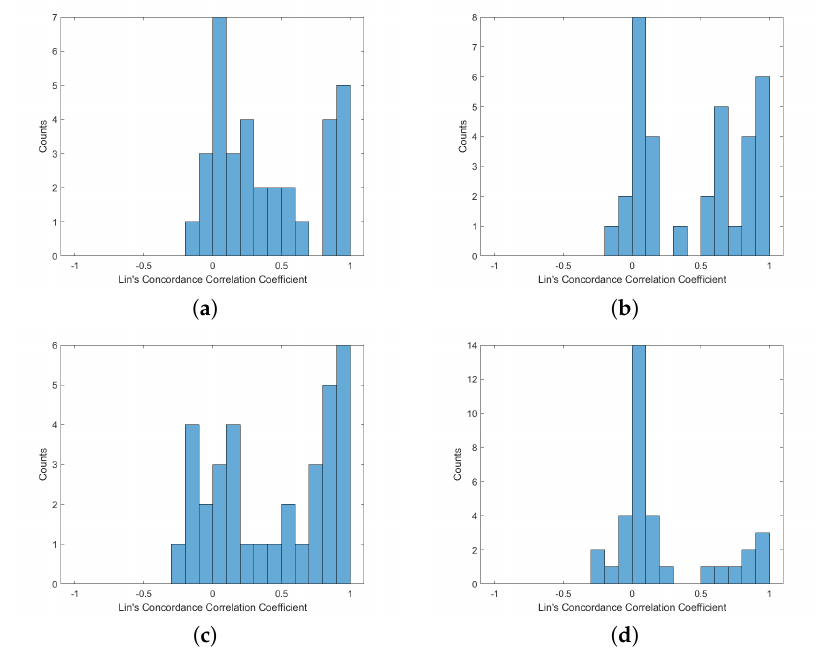
Figure A4. Histogram of Lin’s Concordance Correlation Coefficient from PPG-HRV and BCG-HRV, position “Up”: ( a ) S1; ( b ) S2; ( c ) S1 and S2; ( d ) all